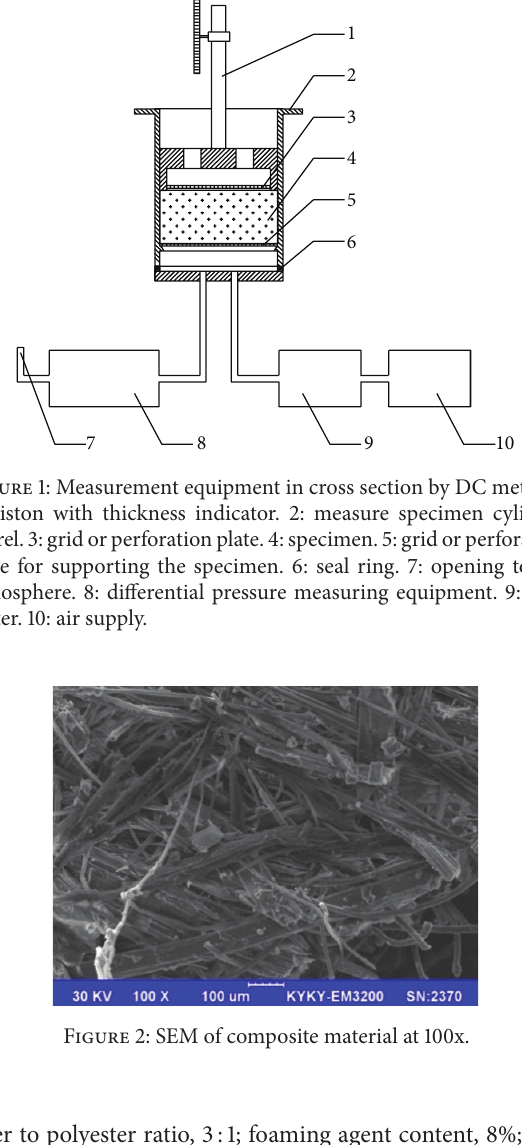
fiber to polyester ratio, 3 : 1; foaming agent content, 8%; and the target density, 0.2 g/cm 3 .